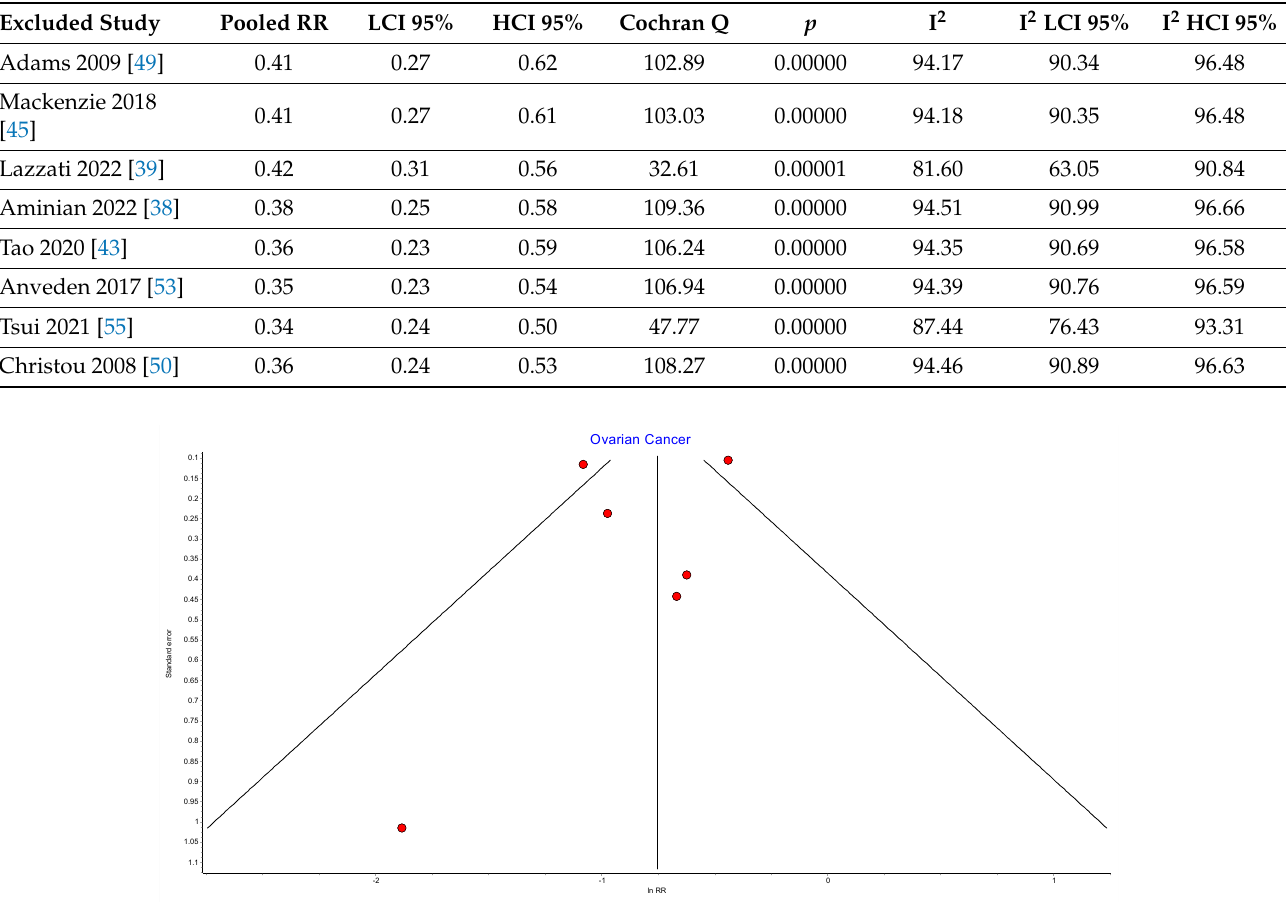
Figure A8. Ovarian cancer random effects model funnel plot. Table A8. Ovarian cancer random effects model sensitivity analysis.